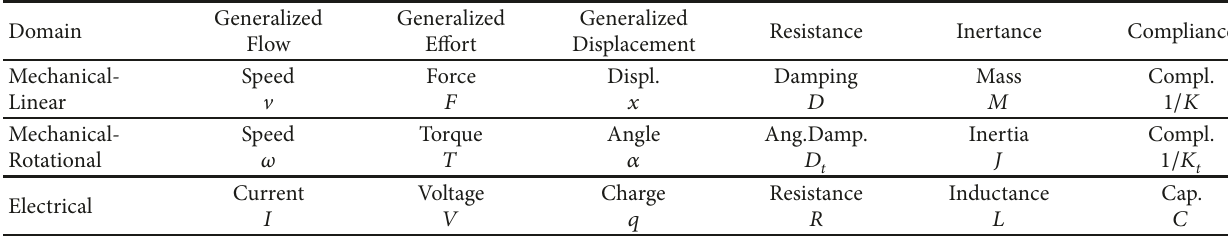
Figure 10: Equivalent 2-DOF mechanical system (series-series topology). Table 4: Equivalence between magnetic and electric systems